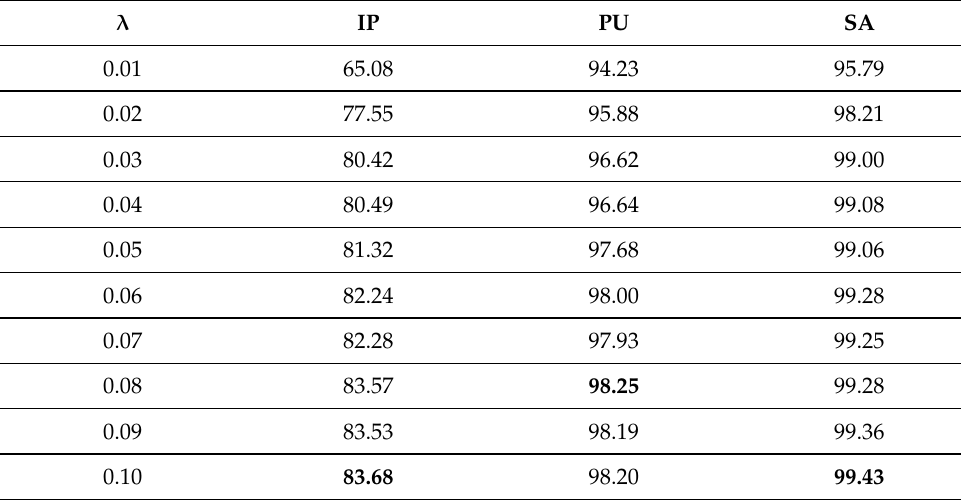
Table 2. The impact of band selection ratio λ on the overall accuracy (OA) of C-CNN-Aug.